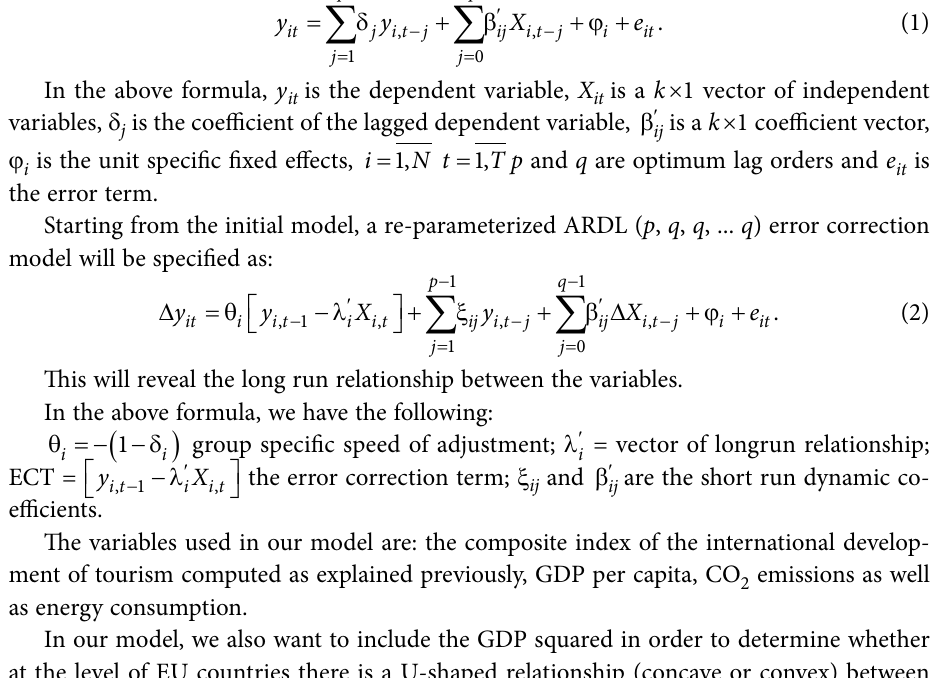
Table 6. Spearman’s rho rank order correlation (source: own computations using SPSS 16) GDP per